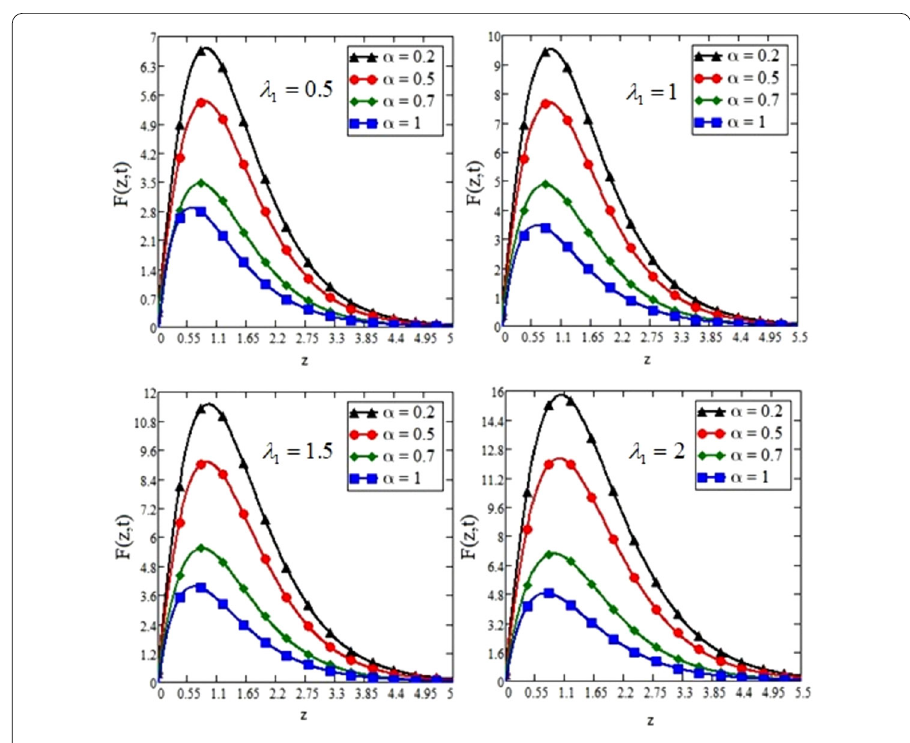
Figure 6 Impact of λ 1 on the velocity distribution of Jeffrey nanofluid